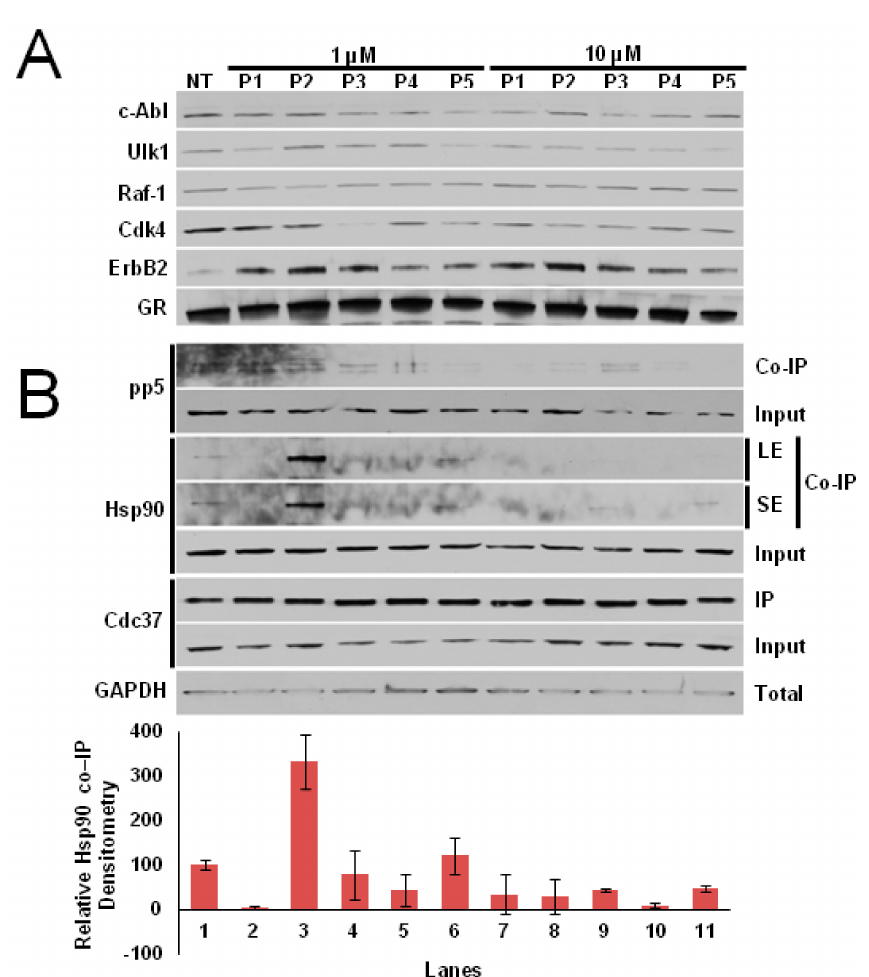
Figure 3. ( A ) Maturation of selected kinases detected by immunoblot assay in the presence of 1 µ M (Lanes 2–6) or 10 µ M (Lanes 7–11) of designed peptides. ( B ) Immunoprecipitation (IP) of Cdc37 in cell lysates in the presence of 1 µ M (Lanes 2–6) or 10 µ M (Lanes 7–11) of designed peptides. LE = long exposure, SE = short